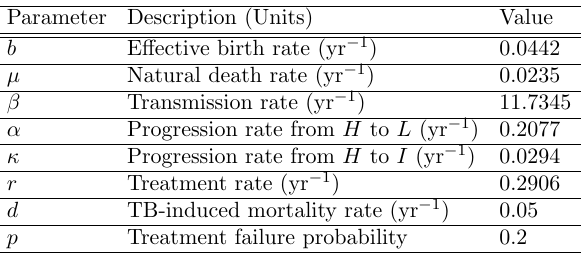
Table 1. Parameters in the